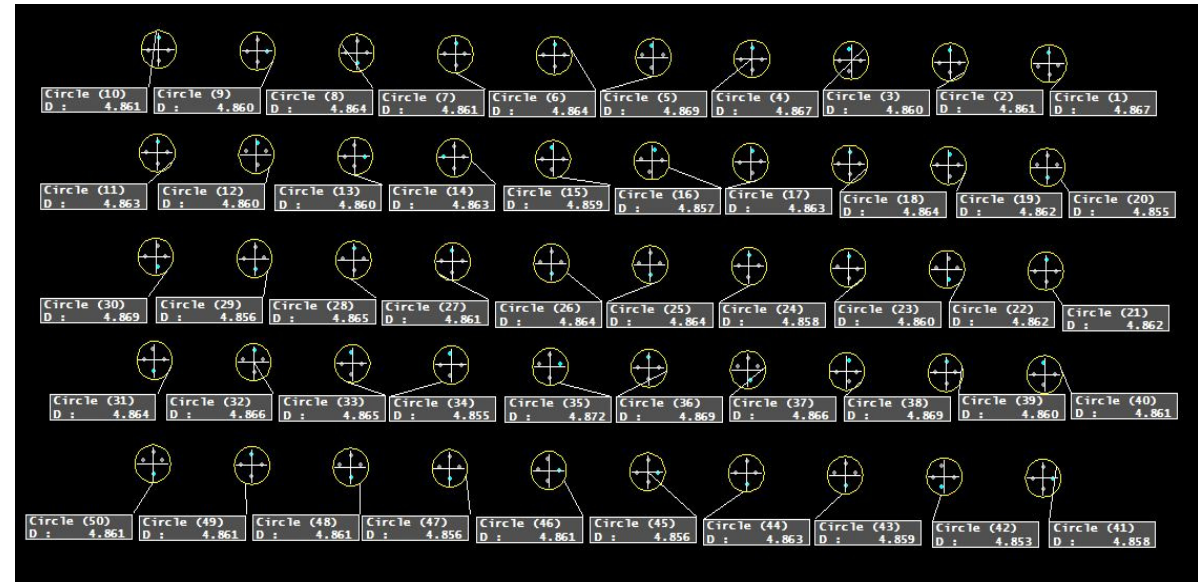
Figure 5. ( a ) Position of probe during measurement of each laminate CFRP and Al7075-T6 ( b ) point of contact for hole diameter measurement and hole circularity measurement.